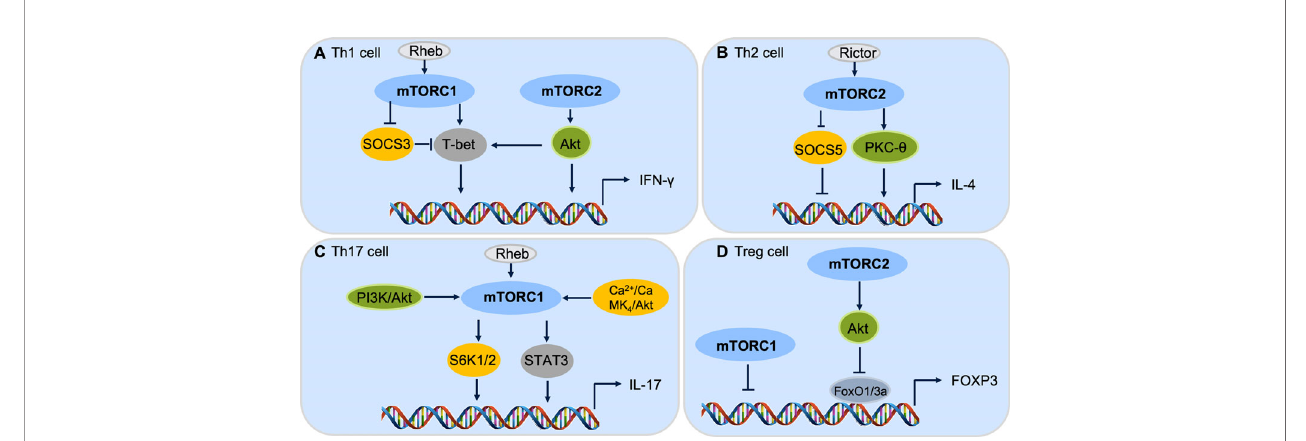
FIGURE 3 | mTOR complexes control CD4 + T cell differentiation. (A) Both mTORC1 and mTORC2 pathways are involved in Th1 cell differentiation. (B) mTORC2, but not mTORC1, cascade regulates Th2 cell differentiation. (C) mTORC1 is critical for Th17 cell differentiation through downstream S6k or STAT3 signaling. (D) Both mTORC1 and mTORC2 cascades are important to repress Foxp3 expression and Treg cell